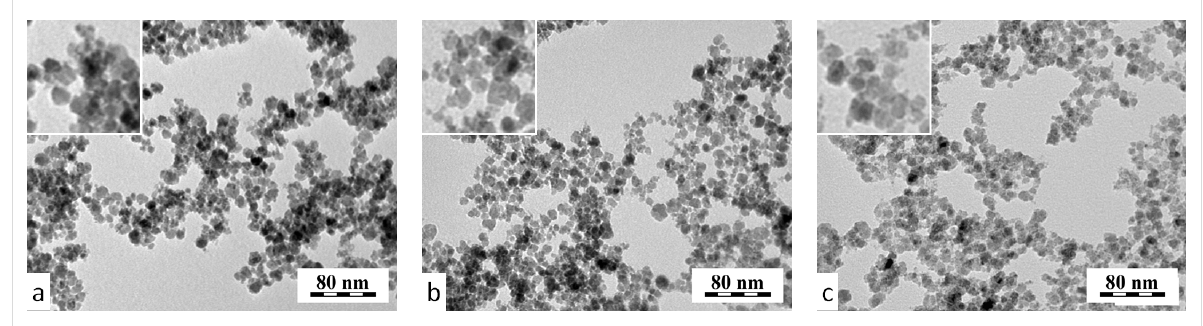
Figure 1: Transmission electron micrographs of (a) non-coated, (b) D-mannose- and (c) PDMAAm-coated γ -Fe 2 O 3